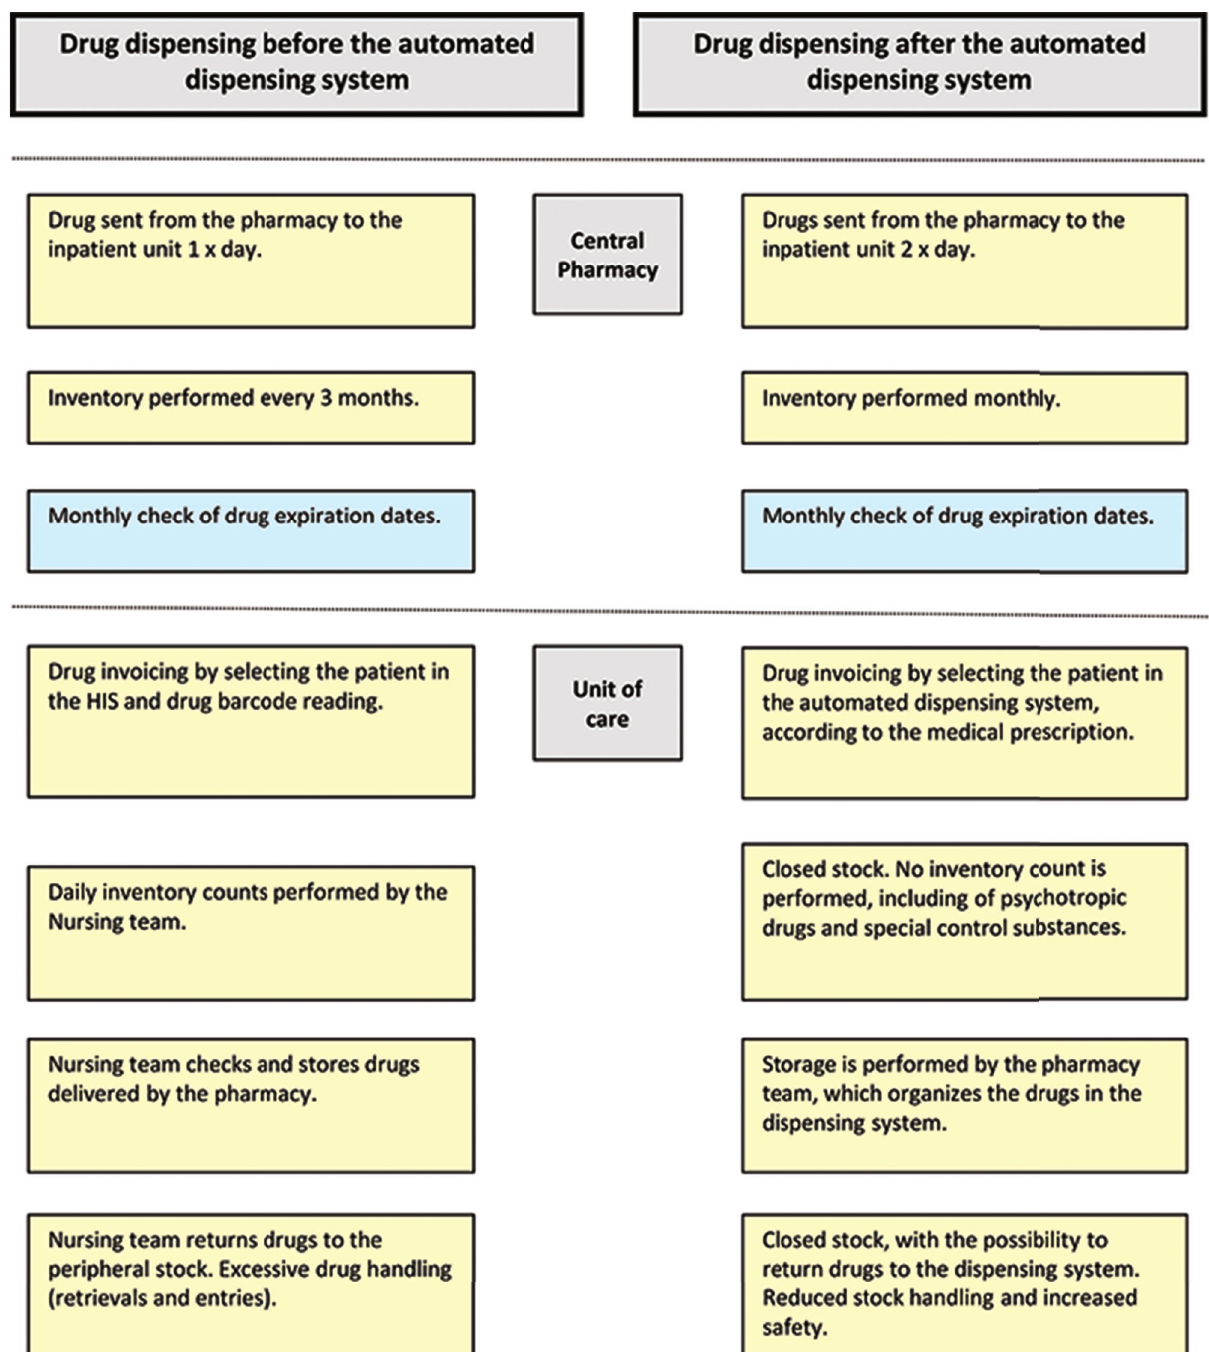
Figure 1 - Drug dispensing before and after implementing the automated dispensing system. Hospital Sı´rio-Libaneˆs, Sa˜o Paulo. Brazil.